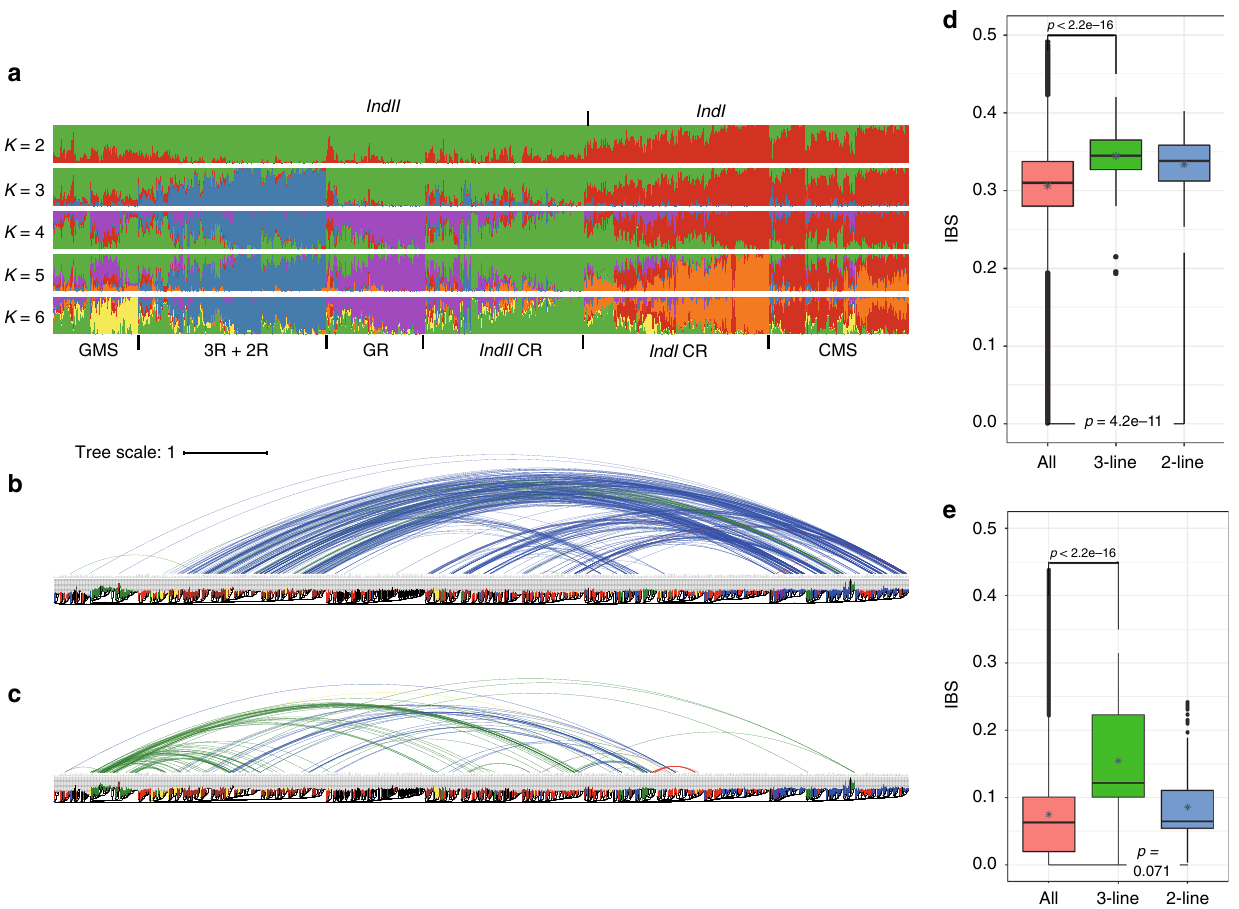
Fig. 2 Genetic analysis of superior indica hybrids. a Population structure analysis of 1143 indica accessions. The results for K values from 2 to 6 are shown. When K = 2, two genetic groups match the IndII and IndI subgroups (see “ Methods ” ). When K = 6, the six genetic groups generally correspond to GMS, restorer (3R + 2R), GR, IndII CR, IndI CR, and CMS lines, with some exceptions in each group. b , c Crossing patterns of the superior 3- ( b ) and 2-line ( c ) hybrids. The top curves connect two parents of superior hybrids: blue: IndII restorers crossed with IndI male sterile lines; green: IndII restorers crossed with IndII male sterile lines; red: IndI restorers crossed with IndI male sterile lines; yellow: IndII restorers crossed with IndII male sterile lines. A nuclear-genome phylogenetic tree in the horizontal format is shown below the curves in the same color schema as in Fig. 1. d Average nuclear-genome genetic distances between two parents for all 1143 accessions ( n = 652,653) and superior 3- ( n = 415) and 2-line ( n = 136) hybrids (all: min = 0.001, max = 0.491; 3-line: min = 0.194, max = 0.420; 2-line: min = 0.253, max = 0.402). e Average mitochondrial genome genetic distances between two parents for all 1143 accessions ( n = 652,653) and superior 3- ( n = 415) and 2-line ( n = 136) hybrids (all: min = 0.000, max = 0.438; 3-line: min = 0.001, max = 0.315; 2-line: min = 0.003, max = 0.242). In d , e , the p values by two-tailed unpaired Welch ’ s t- tests are shown on diagrams. Data representation: the middle line: median; the asterisk: mean; the lower and upper hinges: the fi rst and third quartiles; the upper whisker extends from the hinge to the largest value no further than 1.5 × IQR (inter-quartile range) from the hinge. The lower whisker extends from the hinge to the smallest value at most 1.5 × IQR of the hinge. Data beyond the end of the whiskers, which were considered as the outlying points, are plotted individually. Source data underlying fi gures b – e are provided as a Source Data fi